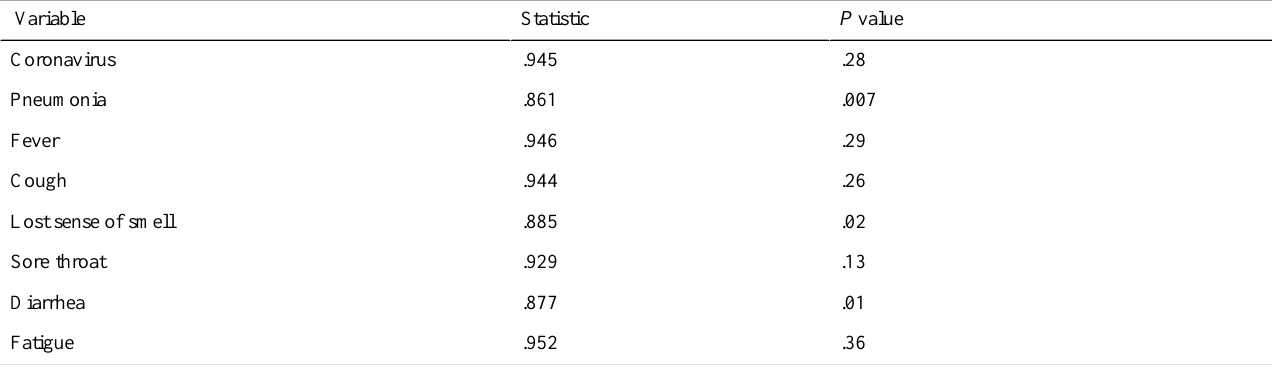
Table 4. Shapiro-Wilk test for normality. The critical region (.908) for a sample size of 21 and significance level of α =.05 was obtained from the critical values of W n,a for the Shapiro-Wilk